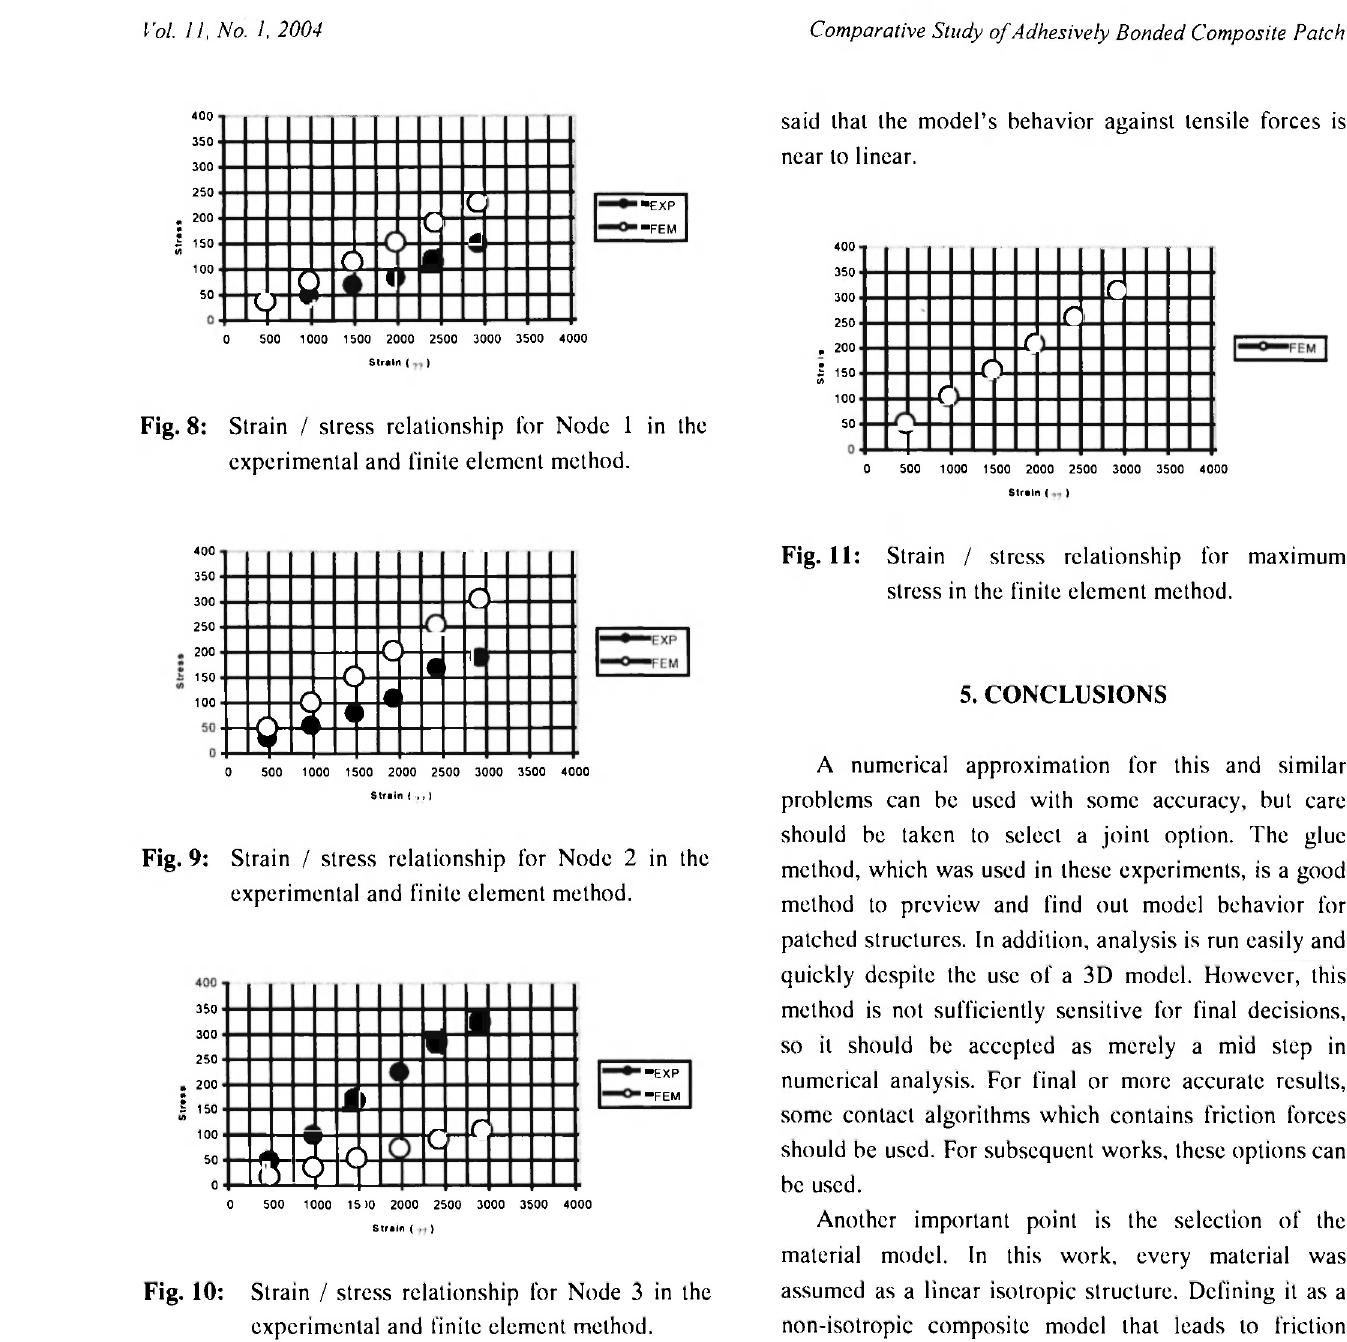
Fig. 9: Strain / stress relationship for Node 2 in the experimental and finite element method.